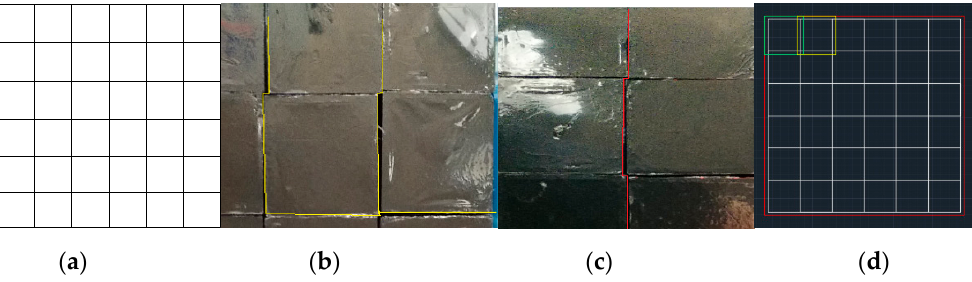
Figure 8. ( a ) The segmentation model in an ideal state, and the terrain is evenly divided into 36 blocks. ( b , c ) The actual probe arrangement in a non-uniform way. Given the actual installation and arrangement of the probe, the ideal uniform cutting method still cannot be selected. The edge of the block needs to be blurred to be expanded on the basis of uniform cutting, as shown in ( d ).